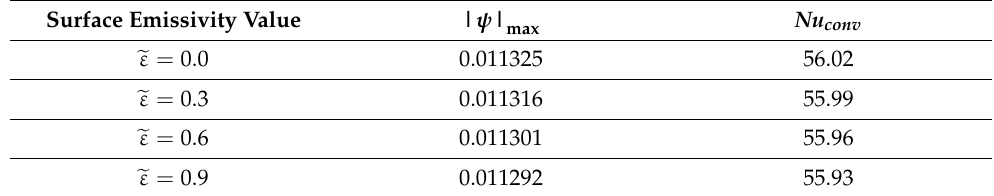
Table 4. Variations of various considered